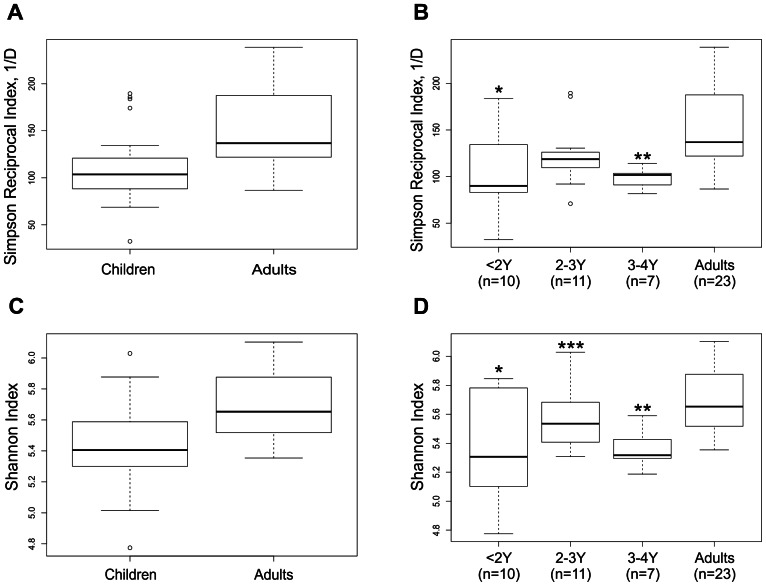
Intestinal microbiota diversity in healthy young children and adults estimated by Simpson reciprocal index (1/D) and Shannon index.The whiskers show the highest and lowest value after excluding outliers (dots). The outliers are defined as more than 3/2 times of upper quartile or less than 3/2 times of lower quartile. Boxplot shows 25th and 75th percentile, with a line at median. The subjects are divided into two groups Adults (>21Y) and Children (<4Y) (A, C) or four groups‘<2Y’, ‘2-3Y’, ‘3-4Y’ and Adults (>21Y) (B, D). A) Simpson index of diversity shows a significant difference between adults and children (p = 0.007), B) Simpson index of diversity shows significant differences between ‘<2Y’and ‘3-4Y’ age groups and adults (*p = 0.006, **p = 0.002 respectively). C) Shannon index of diversity shows significant difference between adults and children (p = 0.001), D) Shannon index of diversity shows significant difference between ‘<2Y’, ‘3-4Y’ and adults, (*p = 0.003, **p = 0.001 respectively). Significant difference is also observed between ‘2-3Y’and ‘3-4Y’ age groups (***p = 0.043).